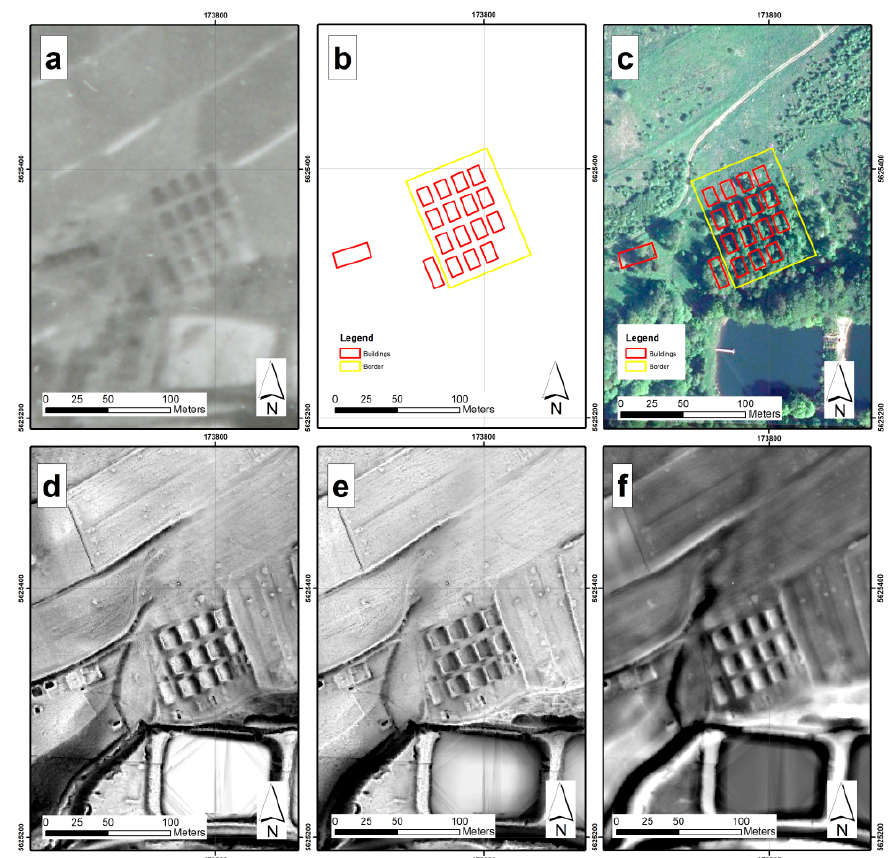
Figure 14. Presumed forced labour camp for Krupp factory in Wüstegiersdorf (Krupp Lager für die Zwangsarbeiter Wüstegiersdorf): ( a ) ’45 aerial photo (© NARA), ( b ) reconstruction of camp based on ’45 photo, (c) recent orthophoto of the area with outlined camp plan (© Head Office of Geodesy and Cartography in Poland), ( d ) SVF image (radius 5m), ( e ) Openness positive image (radius 10m), ( f ) Local Dominance image (min./max.: 10m – 10m). Coordinate grid: UTM Zone 34 N (EPSG: 32634).